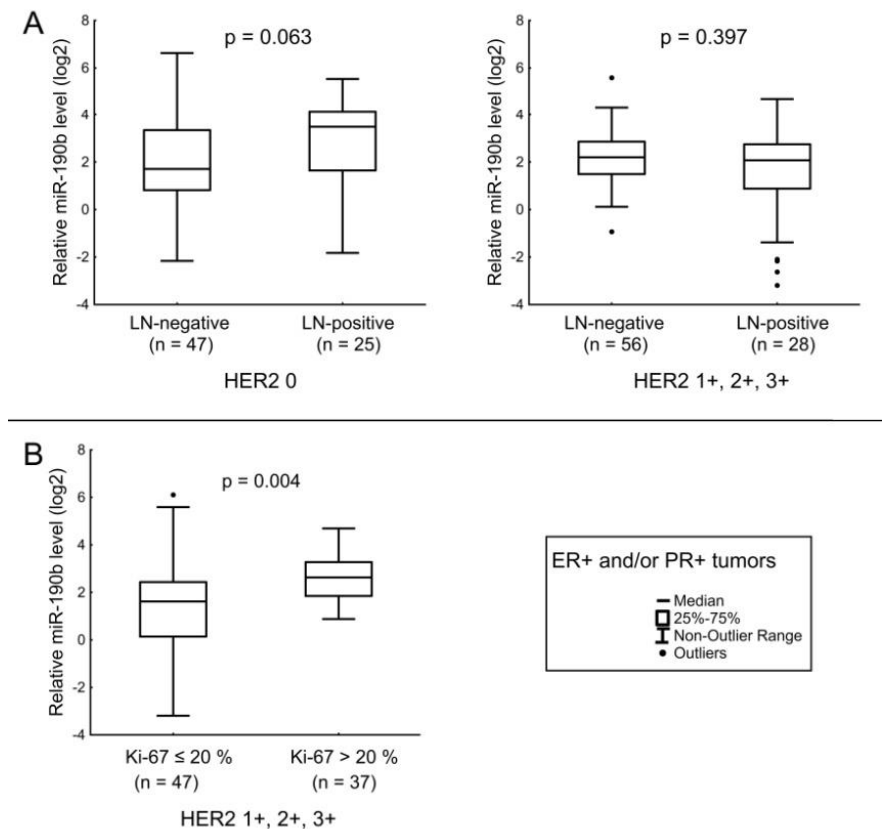
Figure 3. The comparison of miR-190b expression between different cancerous tissue groups: ( A ) relation of miR-190b level with the LNM in tumors with HER2 IHC score 0 (left), relation of miR- 190b level with the LNM in tumors with HER2 IHC score 1+, 2+, 3+ (right); ( B ) relation of miR-190b level with Ki-67 in tissues of patients with luminal HER2-expressing BC (20% was the median value of Ki-67 index). The Y axis presents the expression level (log 2 – ∆∆ Ct ); the results were normalized to the control (normal tissue).